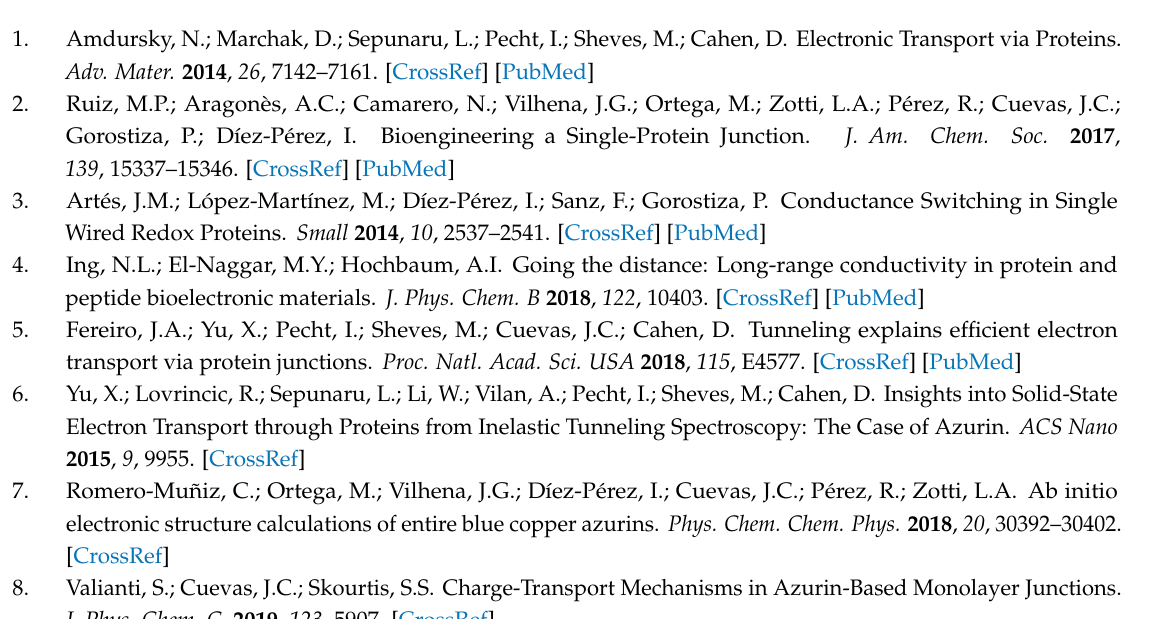
s1; Figure S1: Side and top views of the initial configurations of the Azurin; Figure S2: Cu-mutation distance distributions obtained from the unrestrained Azurin simulations in water; Figure S3: Evolution of the minimum distance between the Azurin protein and its periodic image during all the MD simulations performed in this work; Figure S4: Structural characterization of the five unrestrained Azurin structures in water; Figure S5: Time-dependence of the protein root-mean-square fluctuation (RMSF) during its unrestrained simulation in water; Figure S6: Evolution of the energy of the system during the unrestrained Azurin MD simulations in water; Figure S7: Characteristics of the MD simulations of the Azurin adsorption process; Figure S8: Principal component analysis for the Apo, wild-type and K41C proteins during their unrestrained dynamics in water; Figure S9: Characterization of the wild-type regions where the β -sheet content is lost during the adsorption simulation; Figure S10: Hydrophobic level description of the protein-surface contacting areas. Supplementary Movie S1: First PCA component of the wild-type Azurin unrestrained simulation in water highlighting vibrations in the cooper coordination sphere; Supplementary Movie S2: First PCA component of the Mutant K41C unrestrained simulation in water highlighting vibrations in the cooper coordination sphere; The pdbs of the four initial wild-type Azurin orientations used for studying the adsorption process of this protein on a gold surface are also